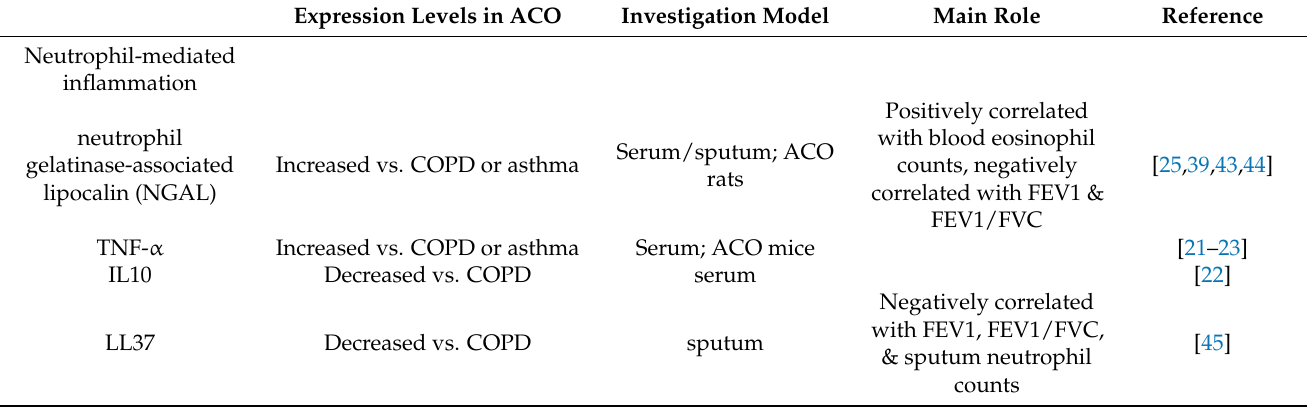
Table 1. Important molecules and their roles in the pathology and clinical phenotypes of asthma and chronic obstructive pulmonary disease overlap